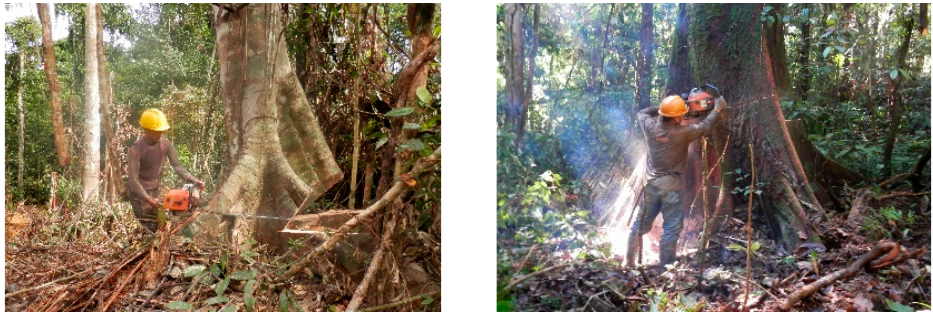
Figure 2. Inappropriate logging activities because chain saw operators have never been trained in reduced impact